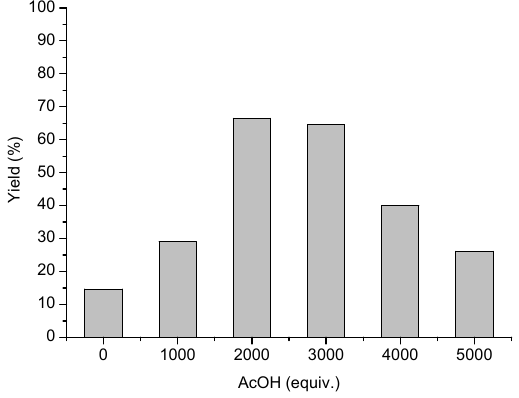
Figure 2. Investigation on acid loading for Mn-SR- meso PYBP(ClO 4 ) 2 -catalyzed epoxidation.